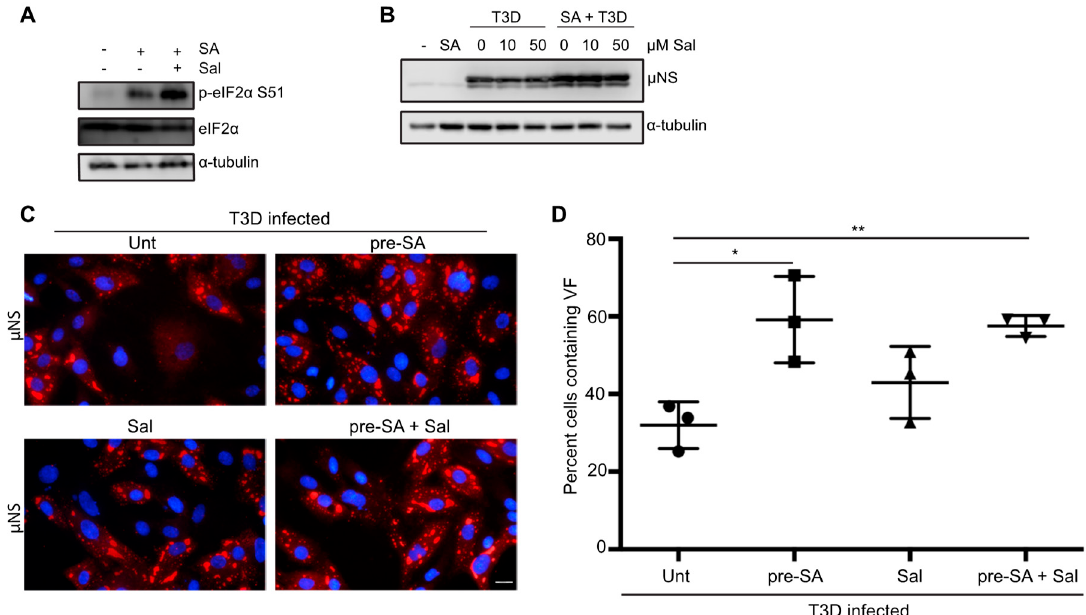
Figure 6. Salubrinal treatment does not negatively impact reovirus infection. ( A ) CV-1 cells were left untreated (-), or were incubated for 17.5 h in the presence or absence of 50 μ M salubrinal (sal) before adding 0.5 mM sodium arsenite (SA) for 30 min. Following the removal of SA at 18 h p.i., the media was replaced and cells were incubated in the presence or absence of 50 μ M sal for an additional 2 h. Cells were then lysed and the expression of the indicated proteins was determined by immunoblot. ( B ) CV-1 cells were either left untreated (-), were pre-treated with 0.5 mM SA for 30 min (SA), or were infected with T3D at an MOI = 10 in the presence or absence of SA pre-treatment. Immediately following infection, salubrinal was added to T3D-infected cells at the indicated concentrations. At 18 h p.i., cells were lysed and the expression levels of the indicated proteins was determined by immunoblot. ( C ) CV-1 cells were left untreated or were treated with 0.5 mM SA for 30 min prior to infection with T3D at an MOI = 1. Following infection, 50 μ M sal was added where indicated. At 18 h p.i., cells were fixed and immunostained for μ NS (red) and DAPI (nuclei, blue). ( D ) The percent of cells containing viral factories (VFs) as represented in panel (C) was quantified ((# of cells containing VFs/total # of cells) × 100) from three independent experiments. * p < 0.05; ** p < 0.01; two-tailed unpaired t test. The error bars indicate S.D. Scale bars, 20 μ m.